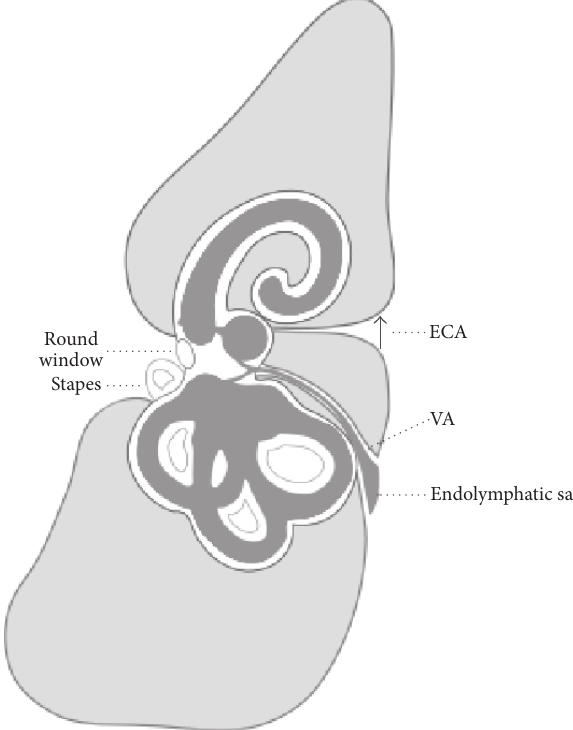
Figure 1: Enlarged cochlear aqueduct (ECA) and vestibular aqueduct